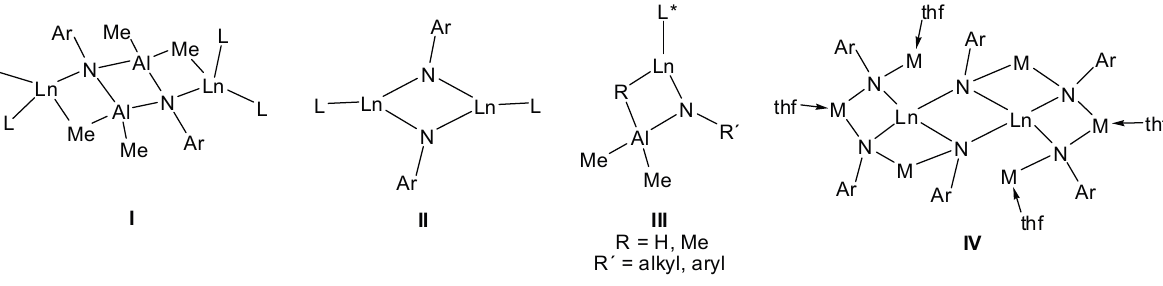
Figure 1. Structural motifs of heterobimetallic rare-earth metal imide complexes: I (L